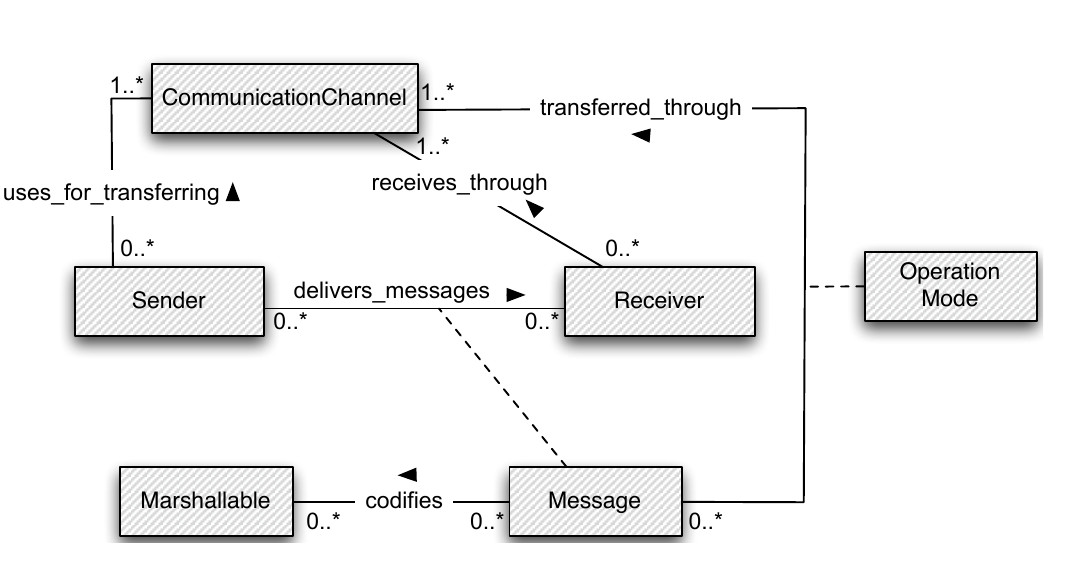
Figure 1. Common model for the PubSub and RR communication